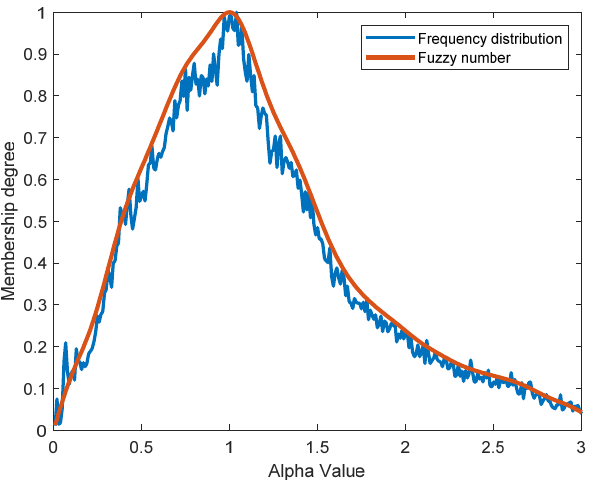
Figure 3. Example of frequency distribution and fuzzy numbers (cid:101) α 3,3